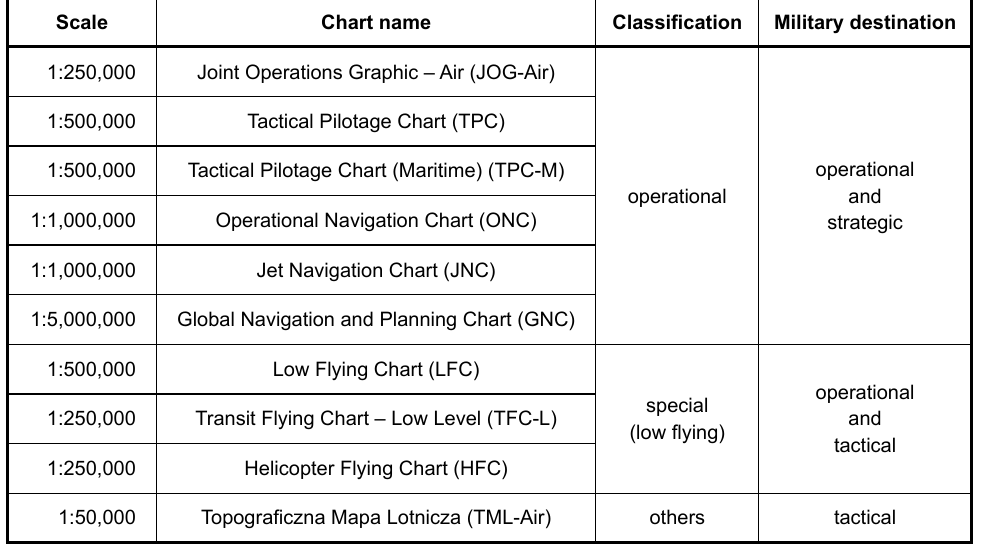
Table 1. Classification of standard military aeronautical charts Scale Chart name